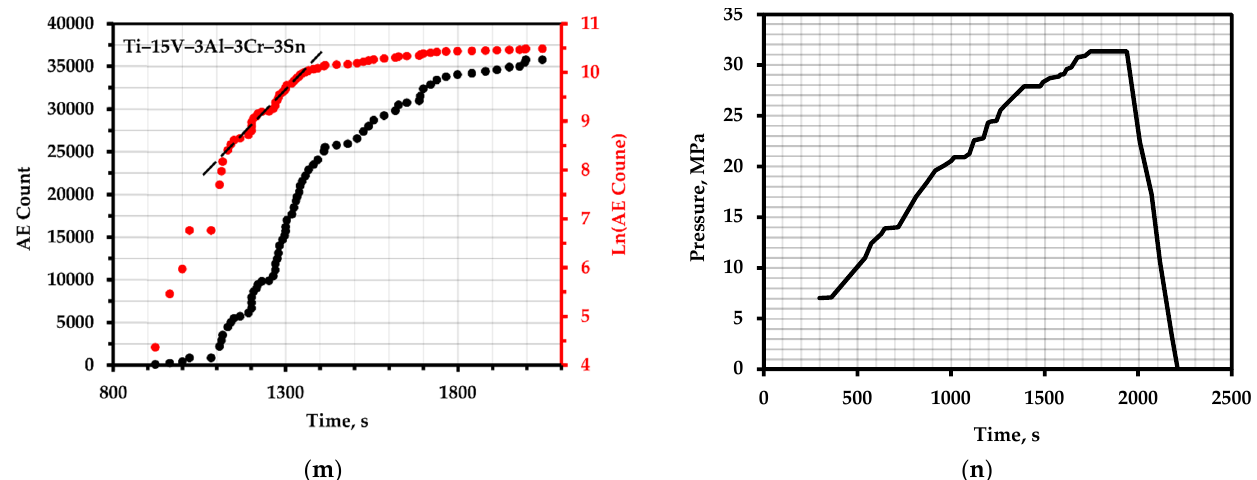
Figure 5. The total AE count and the logarithm of the total AE count over time: ( a ) nickel alloy 625+; ( c ) tool steel D2 (sample E3); ( e ) AISI 304 steel with 24 h exposure; ( g ) AISI 1060 steel; ( i ) A572 steel of grade 50 with a deformation value of 0.072; ( k ) M250 steel with hidden defects; ( m ) vessels made of Ti–15V–3Al–3Cr–3Sn alloy; ( b , d , f , h , j , l , n )—corresponding loading schedules.